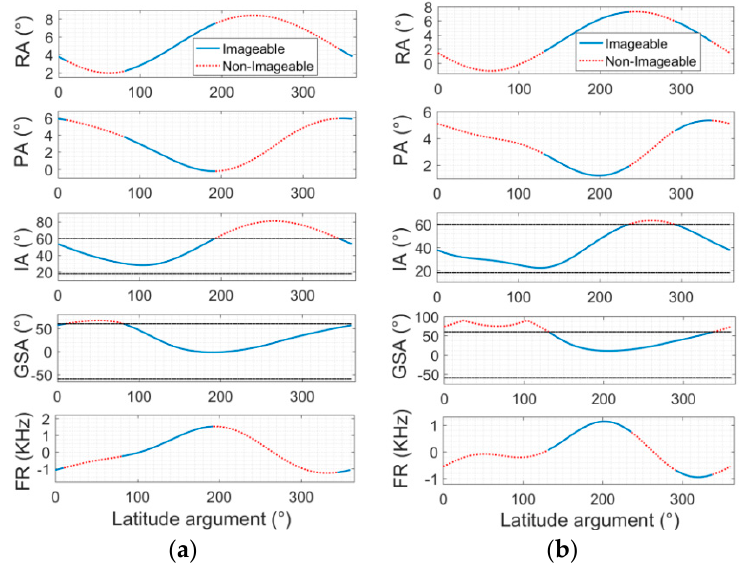
Figure 7. The imageable track segment when Geo-SAR, respectively, stares at Beijing, and Hong Kong in the whole orbital period by using 2D-PRSC technology. ( a ) Beijing. ( b ) Hong Kong. The total imageable time in a whole orbital period of 24 h for staring at Beijing is about 9.3 h, and that for Hong Kong is about 10.4 h.